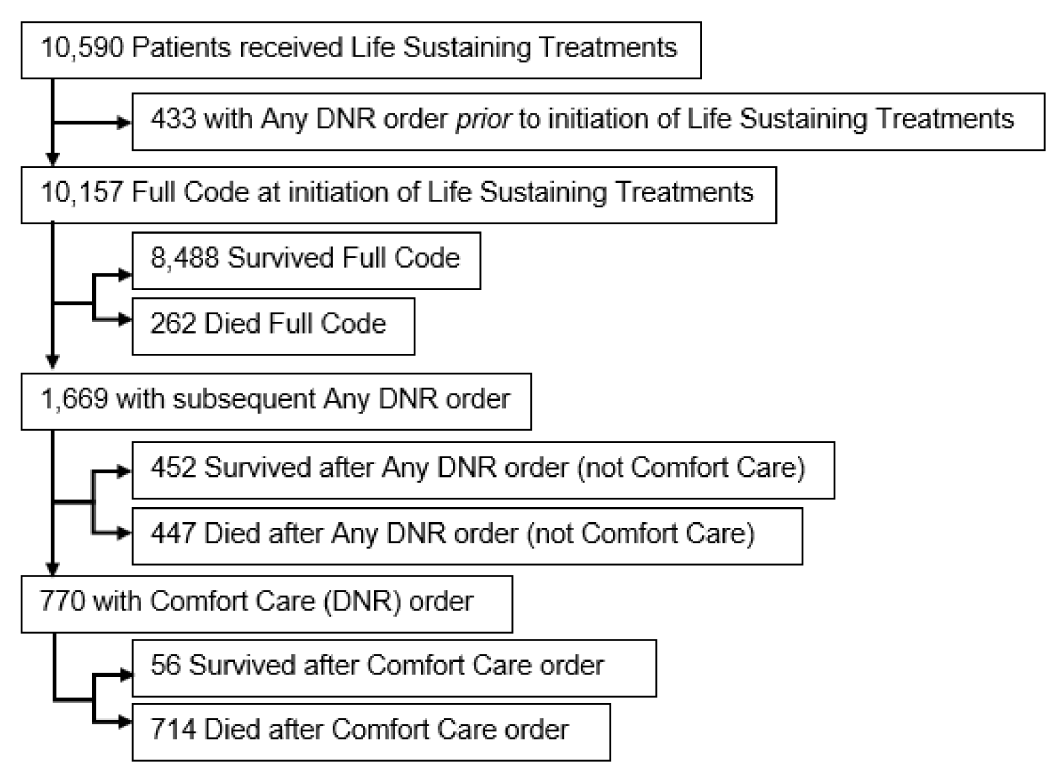
Fig 1. Flowchart of patients receiving life sustaining treatments, code status orders, and in hospital mortality.